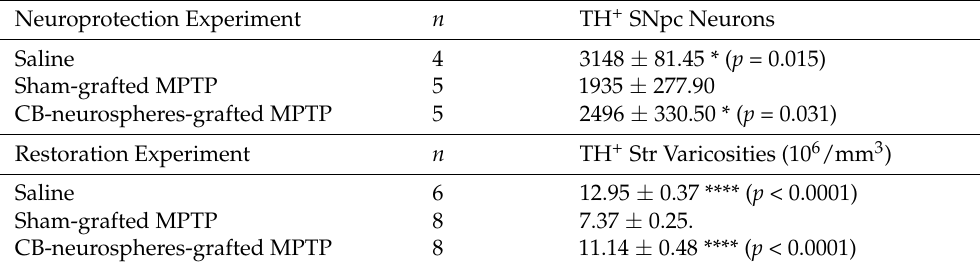
Table 1. Stereological analysis of dopaminergic nigral neurons and striatal varicosities. Neuroprotection